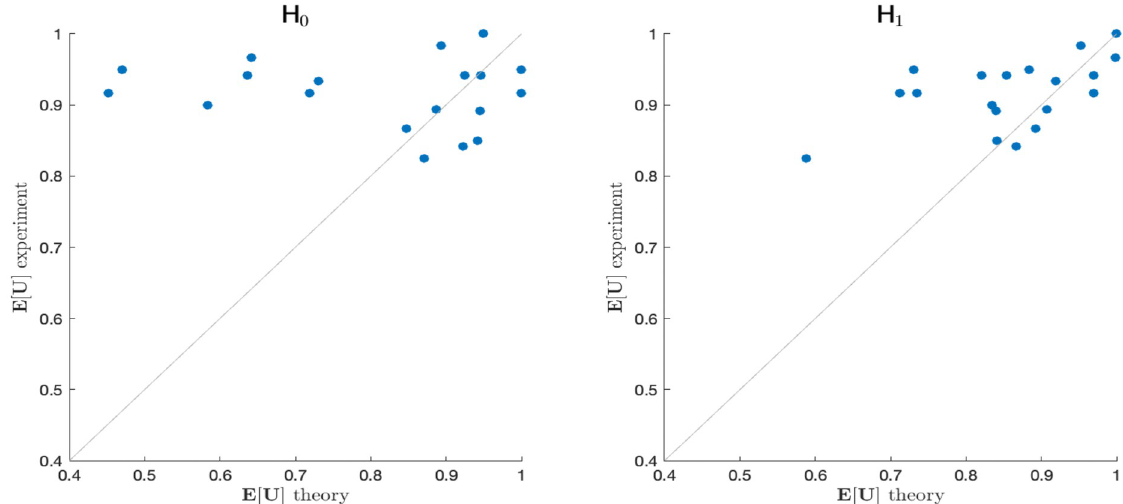
Fig 7. Comparison of experimental and theoretical performance. Linear regression analysis of theoretical E ½ U � averaged across model predictions over all planning related ROIs (DLPFC, PMd, SPLl, antIPS, AIC, cer6, cer8; compare Fig 6A) under both model hypothesis H 0 (left) and H 1 (right) and experimental utility (1—error rate) for the group of subjects. Whereas under model hypothesis H 0 , individual E ½ U � resulting from model fits and subjects fMRI data was not significantly correlated to measured experimental utility (linear regression with p = 0.555, correlation coefficient ρ = − 0.145 and regression slope m = − 0.535), under H 1 a significant correlation between measured data and estimated data was found ( p = 0.0238) with correlation coefficient ρ = 0.516 and regression slope m = 1.171. Better experimental performance in individual subjects than theoretically optimal performance can be plausibly explained by the fact that after the delay phase subjects could still improve their behavior through additional planning following the second cue, whereas the theoretical optimum is computed for planning only with the first cue. Linear regression with shuffled experimental data was repeated for result validation. For shuffled data, only 3.5% of correlations were significant with correlation coefficients ρ in the range of [-0.671, 0.608] and regression slopes m in the range of [-1.524,